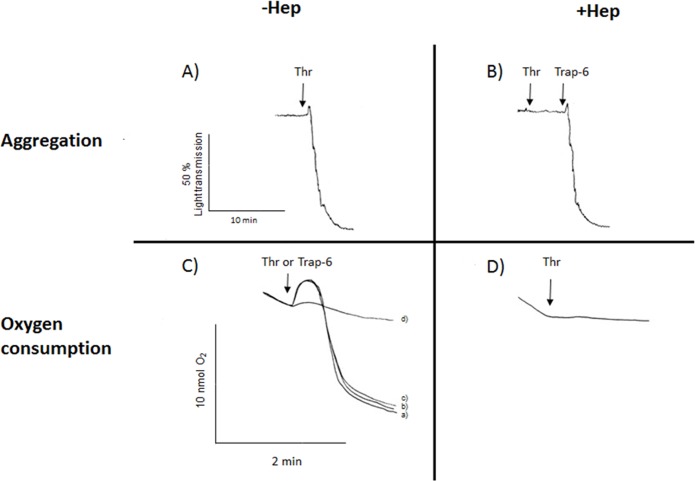
Effect of PAR-1 activation or GPIb inhibition on OxPhos stimulation induced by thrombin.Platelet aggregation (A,B) and oxygen consumption (C,D) were measured in thrombin (Thr) or Trap-6 stimulated platelets. Platelet rich plasma was incubated for 3 min with 1.5 mg/mL heparin (Hep, B,D) at 37°C under constant stirring. Afterwards, 0.5 U/mL thrombin or 22 μM Trap-6 was added as indicated by arrows. In (C), thrombin (a-c) was added in the presence of tirofiban (70 mg/ml) (b) or aspirin (1 μM) (c). In (d) only Trap-6 was added.